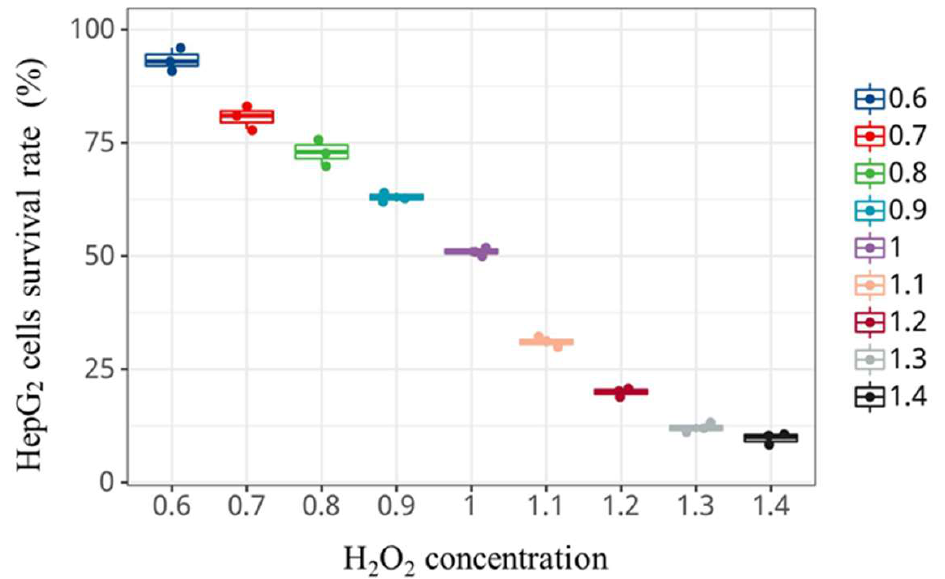
Figure 2. The effect of H 2 O 2 concentration on the survival rate of HepG2 cells.